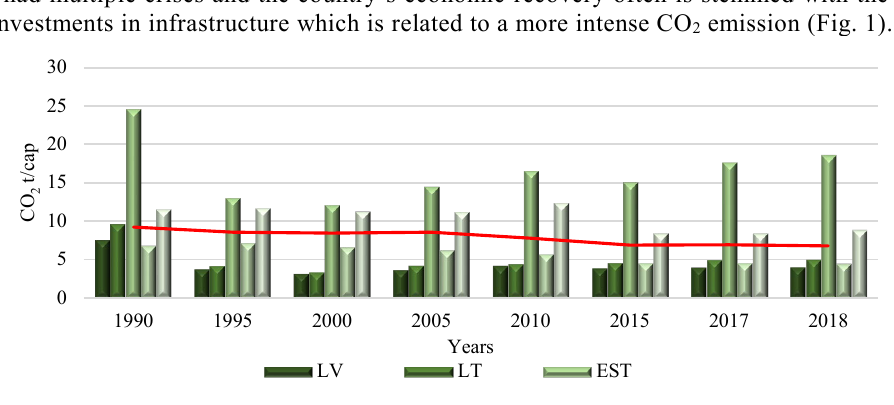
Fig. 1. Fossil CO 2 per capita emissions, CO 2 t /cap